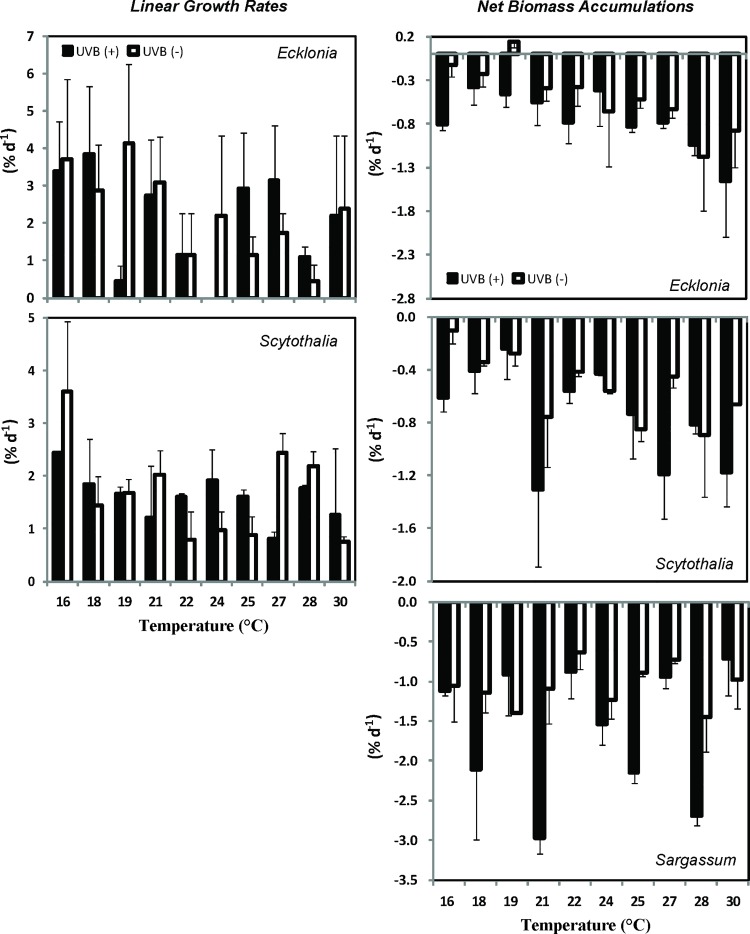
Linear growth rate (LGR) and net biomass accumulation (NBA) of Ecklonia, Scytothalia and Sargassum cultivated at 16 to 30°C, with (UVB (+), filled bars) or without (UVB (-), open bars) exposure to ultraviolet B radiation.Values shown are means ± standard errors.